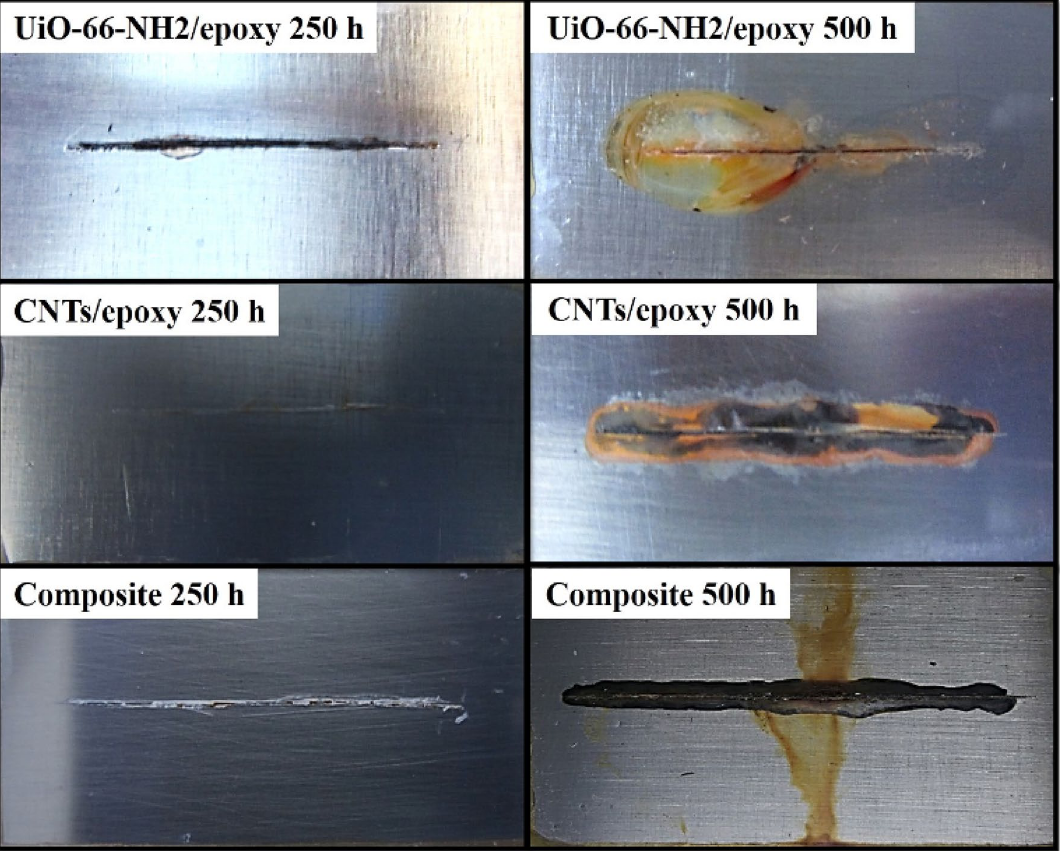
Figure 8. Visual performance of different epoxy coating samples with artificial scratch exposed to salt spray test over